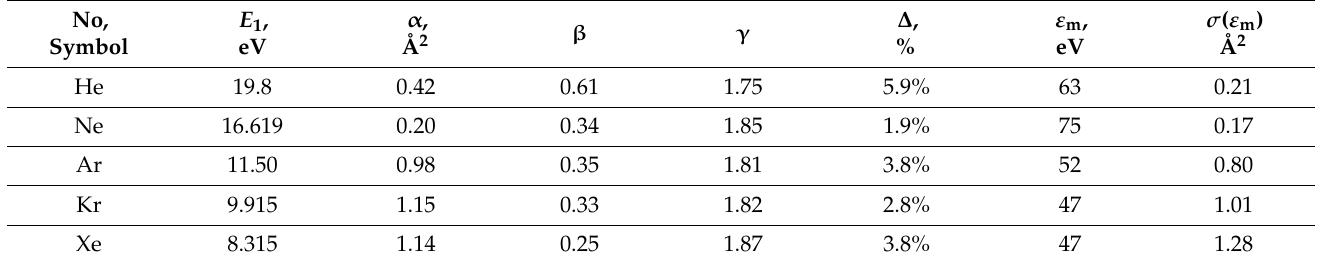
Table 2. Parameter values for approximating the excitation cross sections of noble gases atoms.